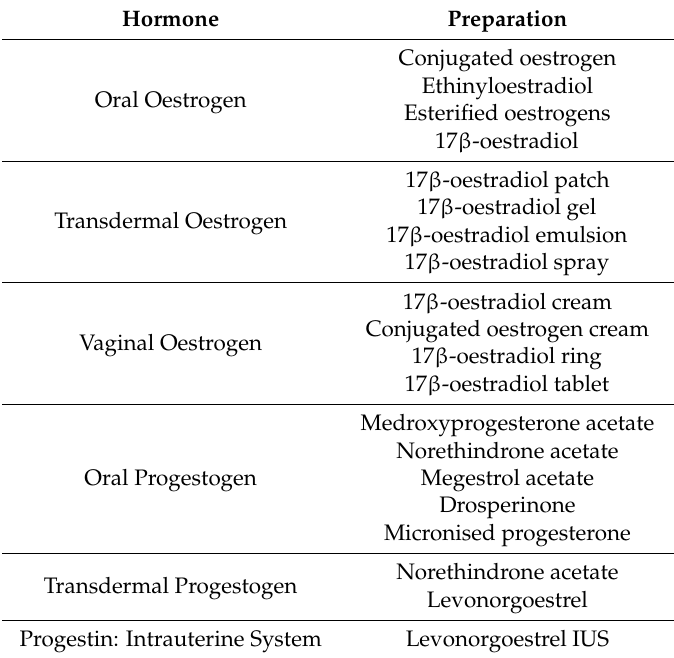
Table 1. Different preparations of oestrogen and